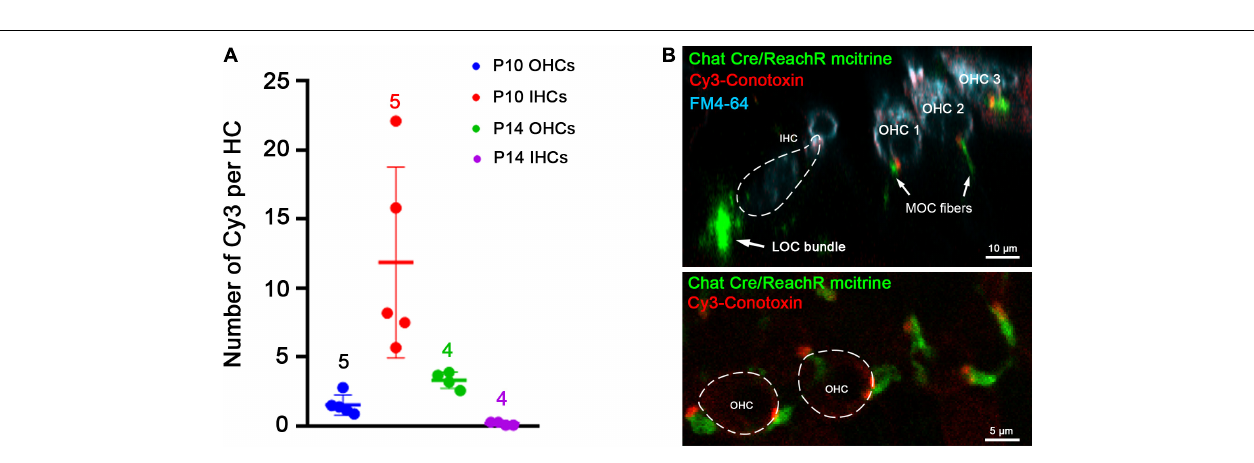
FIGURE 6 | Cochlear location of Cy3-RgIA-5727 puncta. (A) Cy3 puncta associated with hair cells were counted in cochleas from C57 Bl6 mice before (P10) and after the onset of hearing (P14). (B) Cochleas from P23 mice expressing the fluorescent protein m-citrine under the ChAT promoter (Chat-Cre) were excised and exposed to Cy3-RgIA-5727 in the presence of 0.1 mg/ml BSA. Cy3-puncta (red) were found under OHCs, but not under IHCs. Note also the absence of Cy3 puncta medial to the IHCs. Cy3-puncta were closely aligned with m-citrine positive efferent terminals (green). See Supplementary Video 3 for 3-D